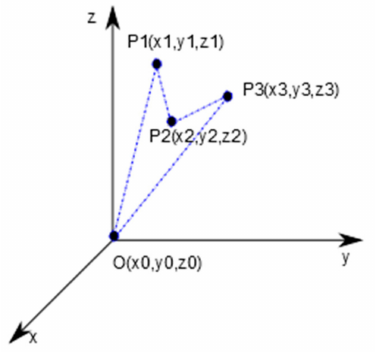
Figure 6. The ideal phase space representation of the “marked” lobe (auxiliary